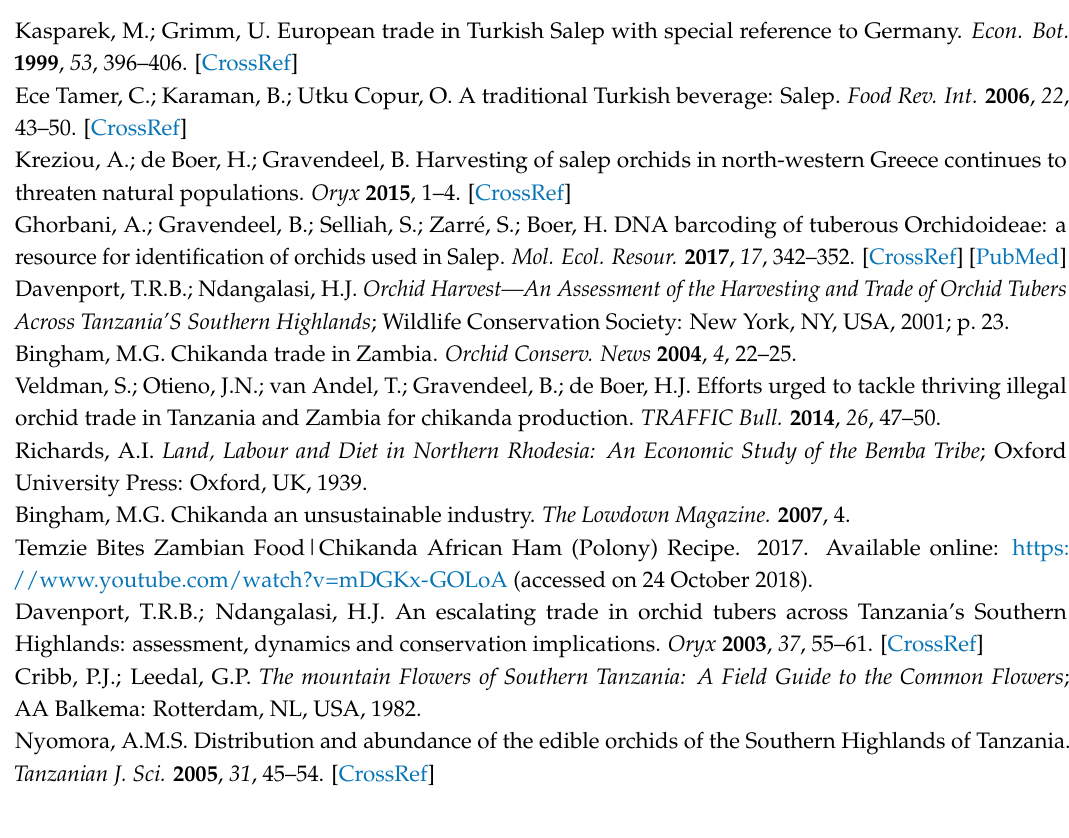
Table S2. Genbank accession numbers of the chikanda tuber sequences. Table S3. Hit table with the first 5 BLAST top hits per sample for nrITS. Table S4. Hit table with the first 5 BLAST top hits per sample for matK. Table S5. Hit table with the first 5 BLAST top hits per sample for rbcL. Table S6. Successfully sequenced samples with their vernacular name, reported origin, identification based on sequence-similarity for nrITS and matK , identification based on the tree-based bPTP analysis and the consensus ID. Table S7. Orchid species used for chikanda according to